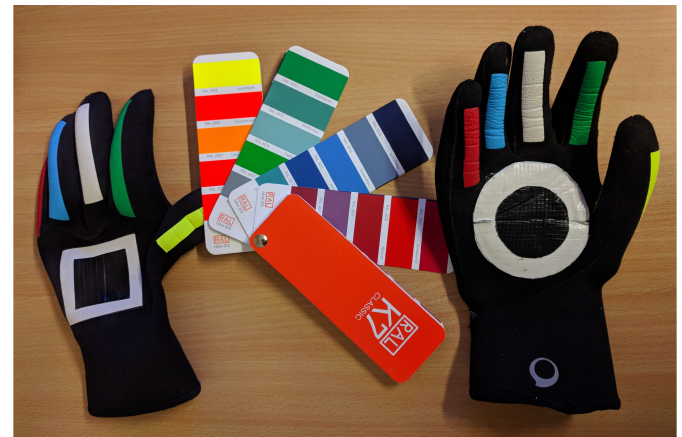
Figure 6. Diver gloves and RAL-K7 chart.